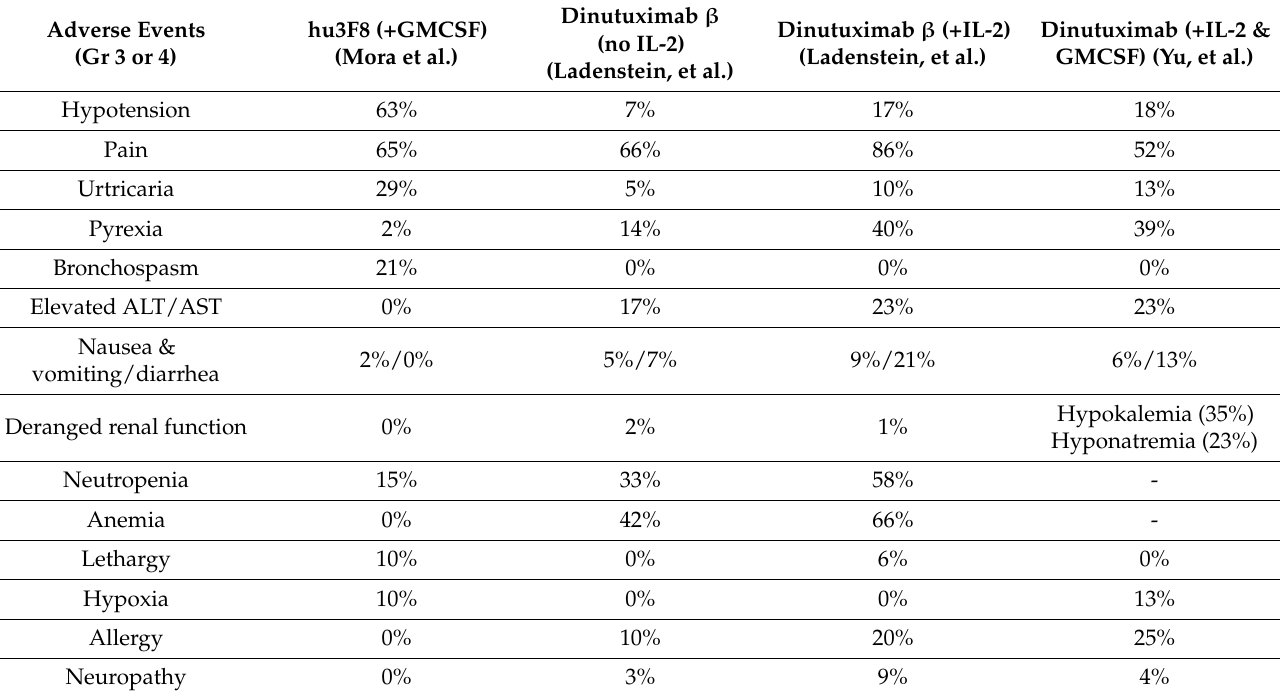
Table 2. Overview of side effects of three commercially available anti-GD2 products based on their respective clinical trials, modified to match symptoms for